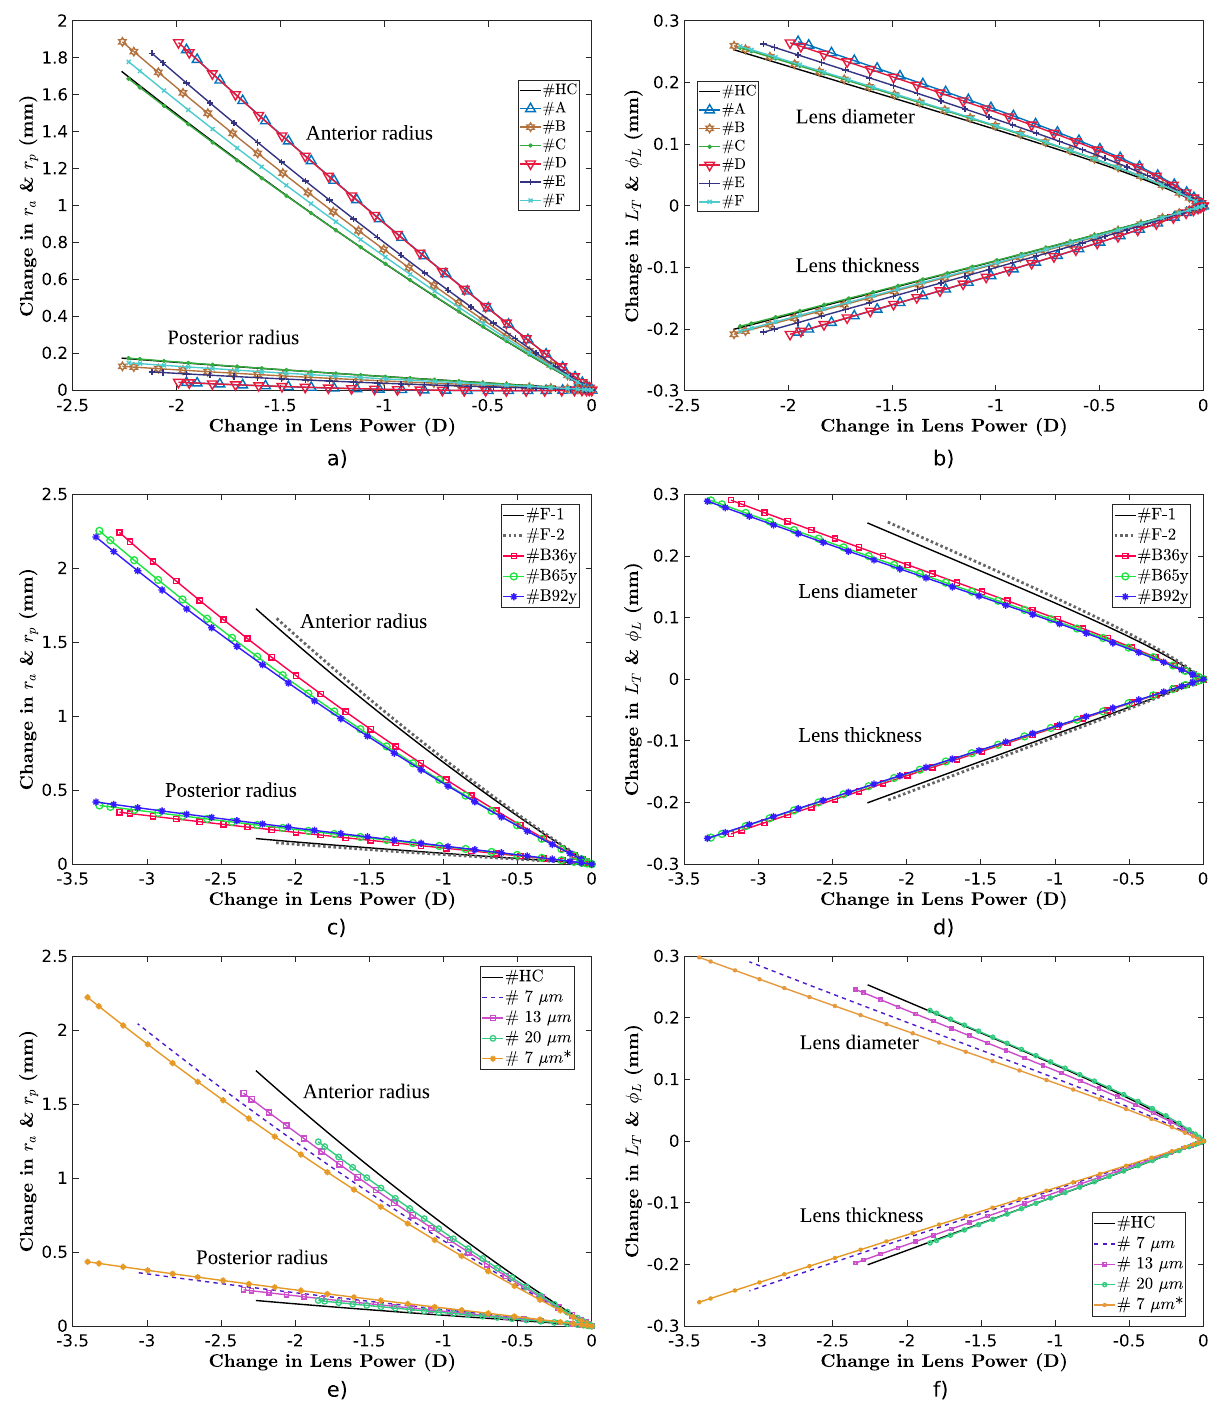
Figure 4. Change in the main biometric parameters of the lens for different case studies according to the focal change of the lens: anterior and posterior radius ( a , c , e ) and lens thickness and diameter ( b , d , f ). ( a ) and ( b ) depict the results for all stiffness gradient scenarios described in “Evaluation of the lens stiffness gradient” section; ( c ) and ( d ), the results for the five experimental distributions of the lens capsule thickness shown in Fig. 3; ( e ) and ( f ), the results for different uniform lens capsule thickness together with the reference scenario (#HC). All calculations were performed for the 29 y/o lens geometry and summarised in Table